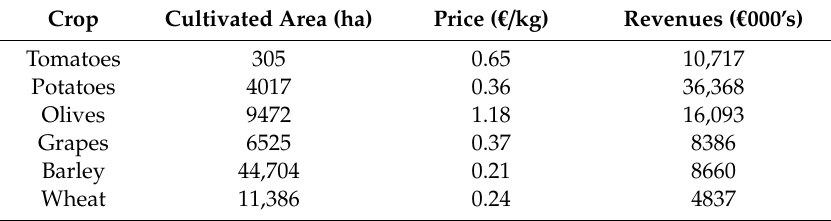
Table 7. Total cultivated area, average price, and revenues for the examined crops in Cyprus